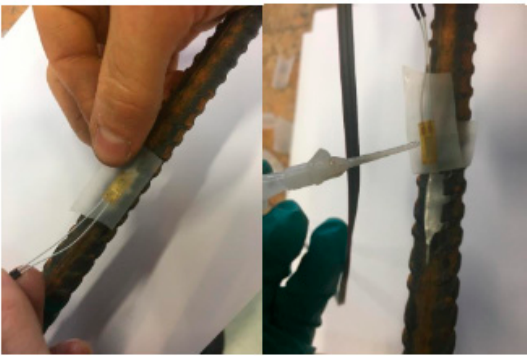
Figure 5. Installing SGs on rebars.